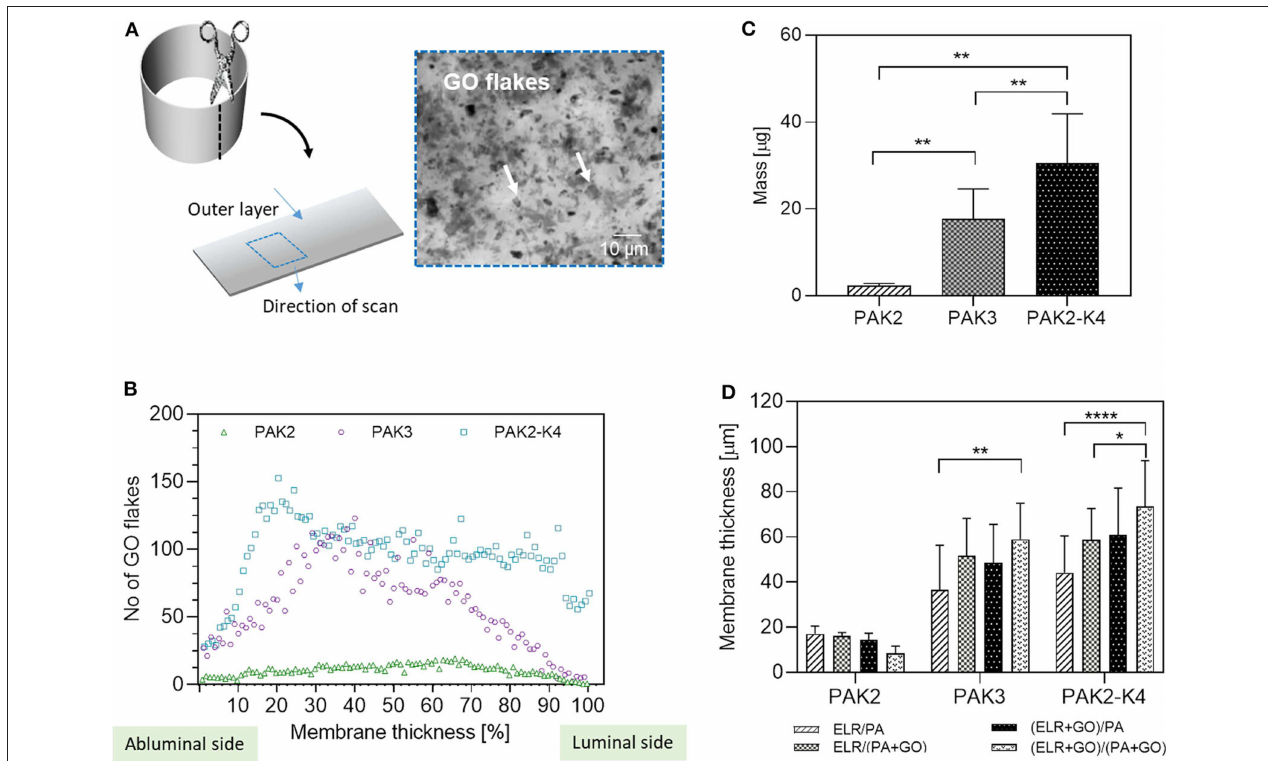
FIGURE 5 | GO content and distribution in the membranes. (A) Schematic of the experimental setup for measuring GO distribution. (B) GO distribution profile throughout the thickness of the ELR5/PAs/GO systems. Number of GO flakes present in each layer of a z-stack image was quantified and presented as number of GO flakes vs. layer number which was normalized as % of the thickness of the membrane. (C) GO content per membrane as measured by UV-Vis. (D) Thickness of the membranes as measured by SEM. Error bars represent ± SD where **** p < 0.0001, ** p < 0.01, and * p < 0.5. The experiments were performed in